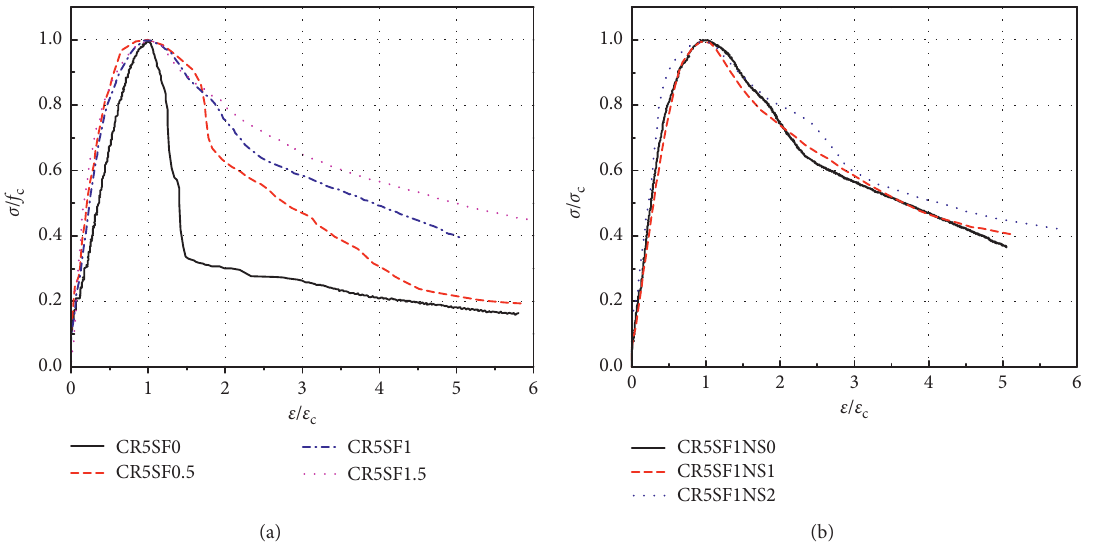
Figure 13: Normalized stress-strain curves of SFNS-CRC with different (a) ]